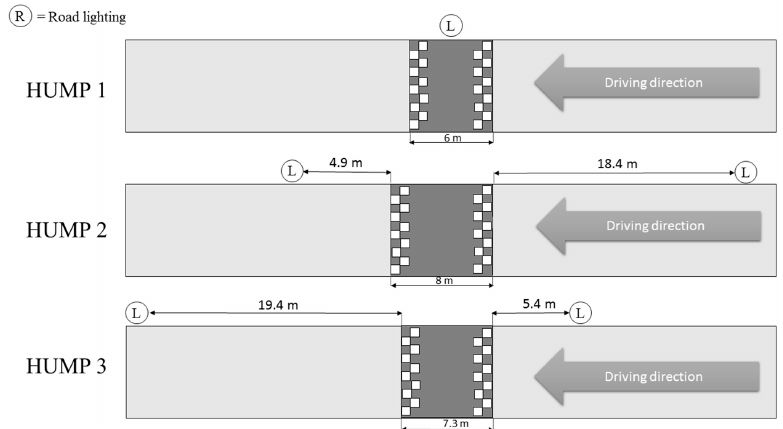
Figure 2. Overview of the location of road lights (L) and speed humps (1–3) and their dimensions and distances (not accurate scales).